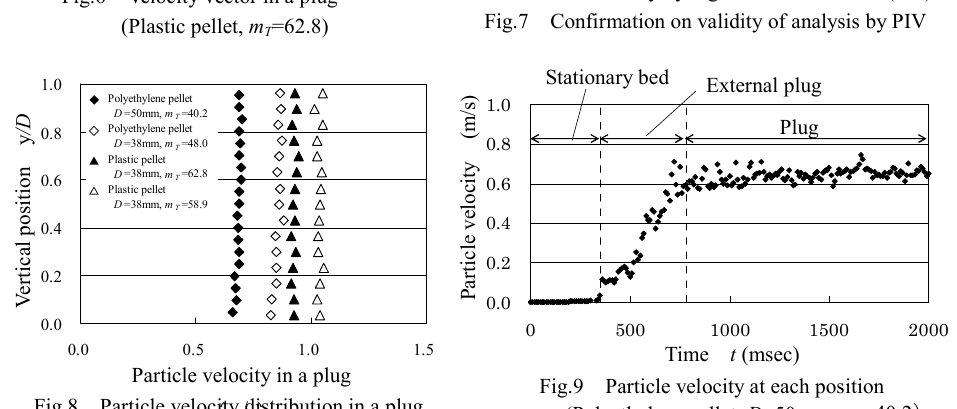
Time t (msec) Fig.9 Particle velocity at each position (Polyethylene pellet, D =50mm, m T =40.2